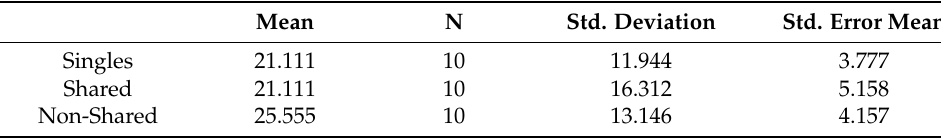
Table 2. Overall descriptive data for test scores improvement in